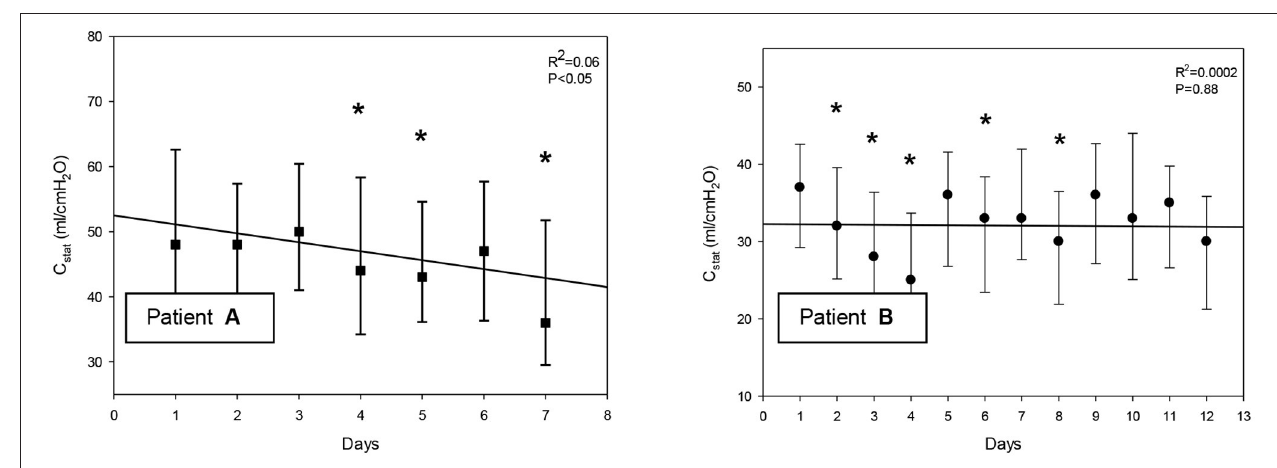
FIGURE 3 | (A,B) Alteration in compliance by moving forward in days. C stat , compliance. Bars represent mean and ± SD . *significant difference as compared to day 1, p < 0.05.